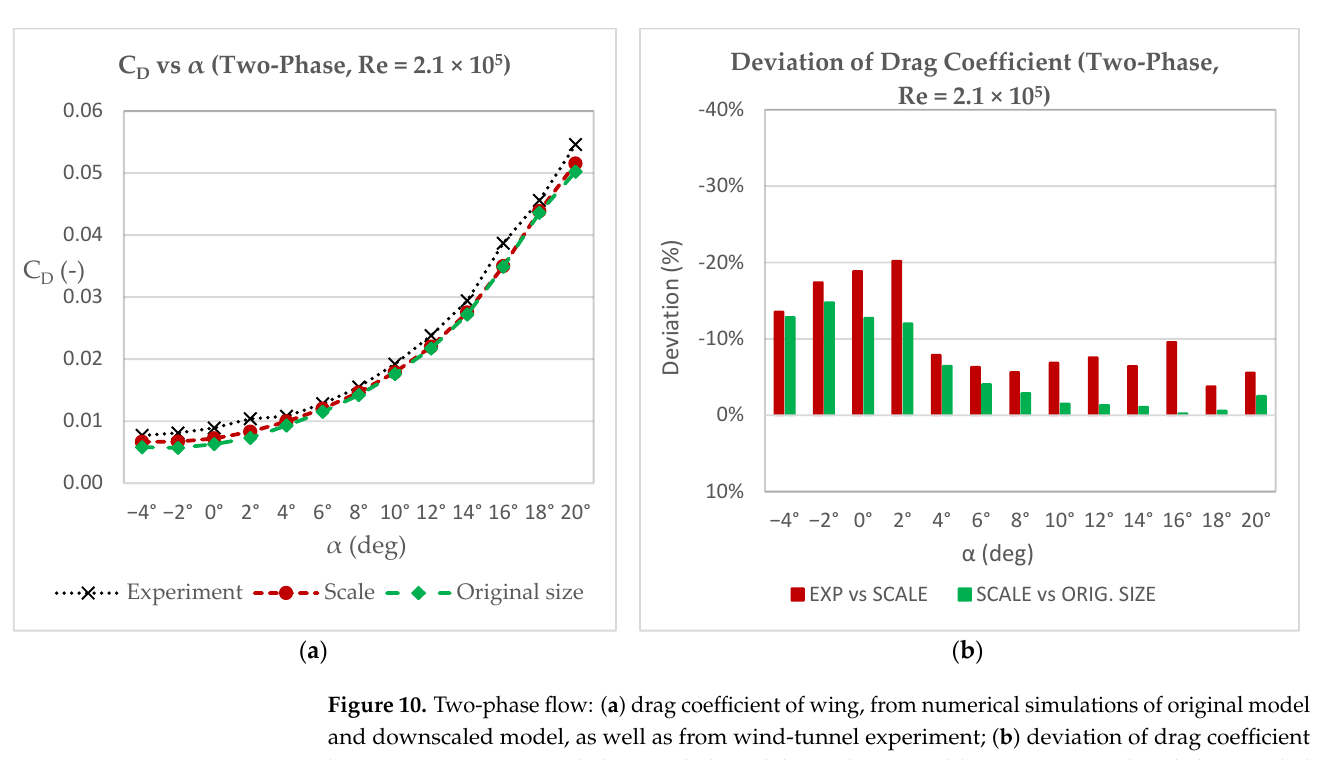
Figure 9. Two-phase flow: ( a ) lift coefficient of wing, from numerical simulations of original model and downscaled model, as well as from wind-tunnel experiment; ( b ) deviation of lift coefficient between experiment and downscaled model simulation and between original and downscaled model simulation.